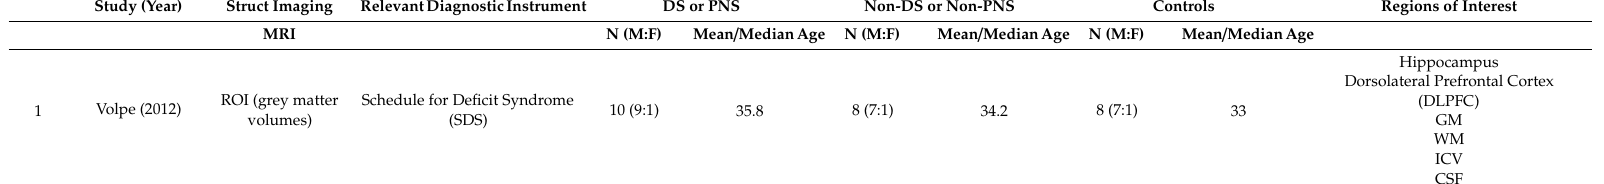
Table A2. Data extraction sheet—demographics and